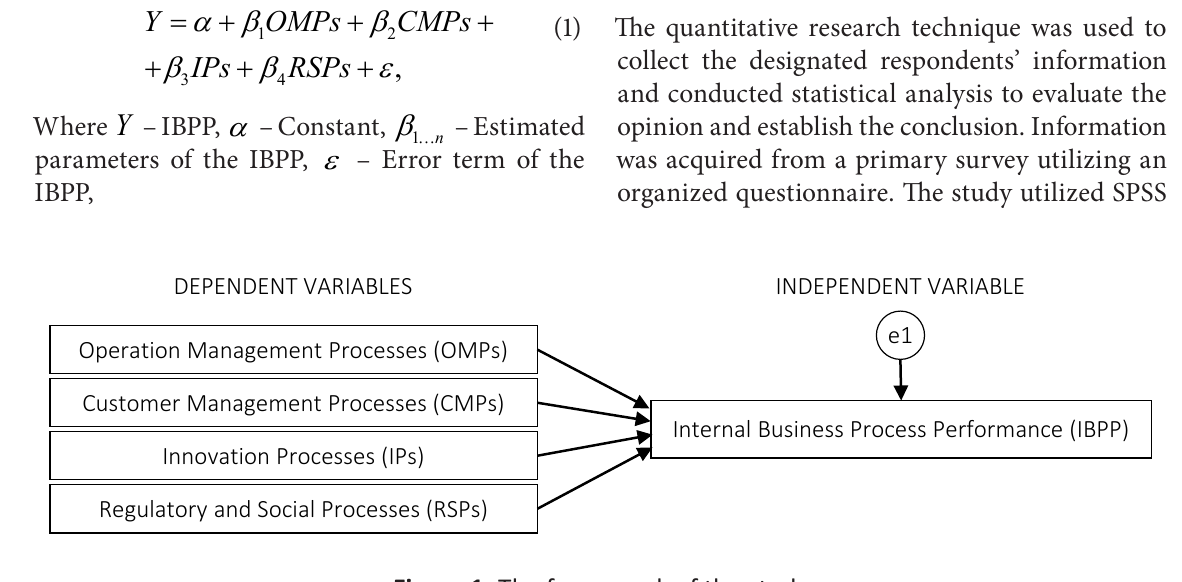
Figure 1. The framework of the study